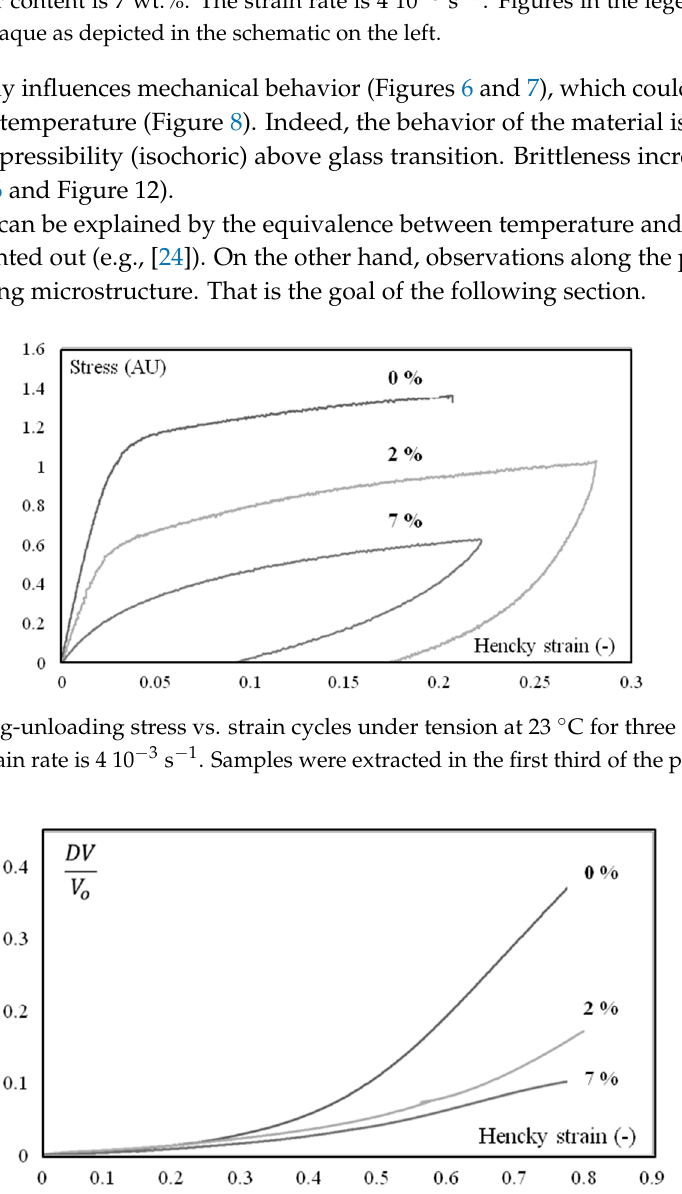
Figure 7. DV/Vo (Equation (2)) as a function of axial strain during monotonic tension conditions at 23 °C for different water contents (in weight). The strain rate is 4 10 − 3 s − 1 . Samples were extracted in the first third of the plaques (close to the gate).